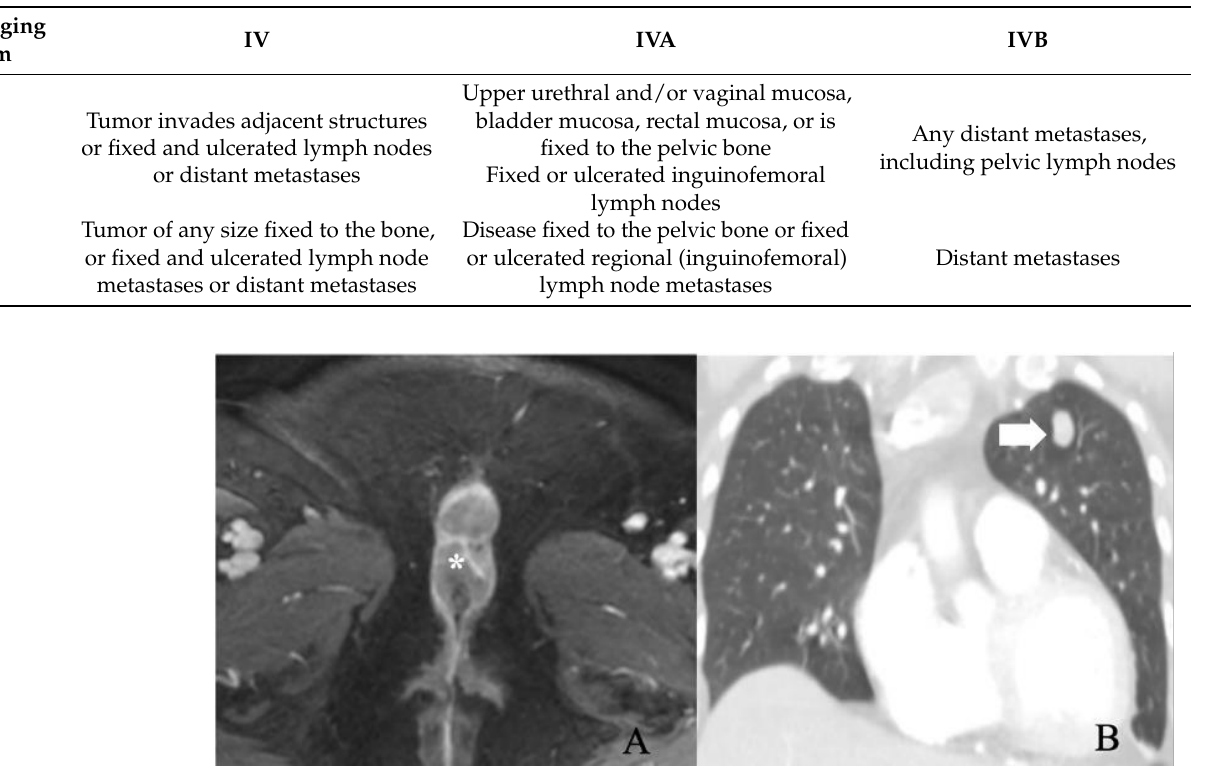
Table 6. International Federation of Gynecology and Obstetrics (FIGO) stage IV definitions.